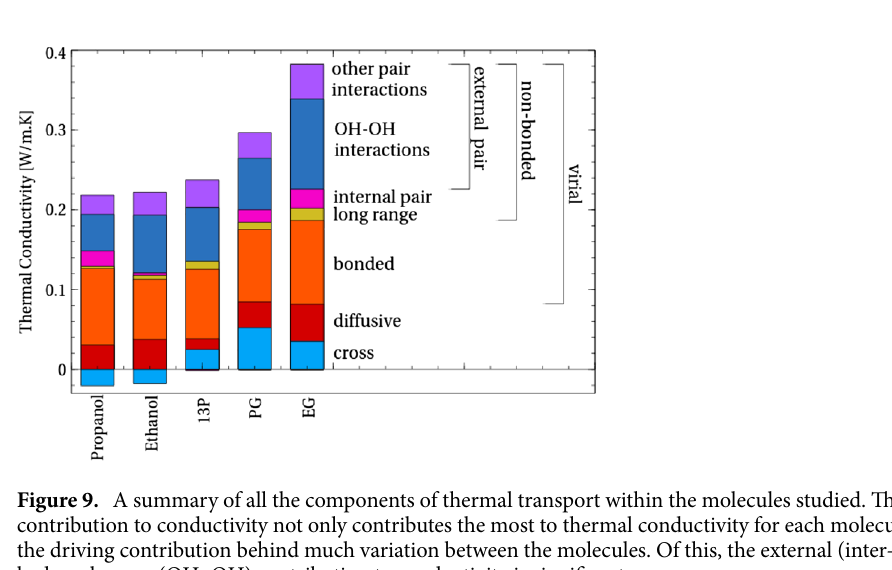
Figure 8. Pearson correlation coefficient map of heat flux correlations between pairs of atoms for ethanol. Correlations that share a single atom type are marked with a star. Oxygen ( O ), carbon ( C ), hydrogen attached to oxygen ( H ) and hydrogen attached to carbon ( h ) are all shown. The inset figure highlights one example of correlations; here between H–C and O–C atoms on two molecules. Note that there may be multiple ways to form each correlation depending on the number of occurrences of the atom type on the molecule.